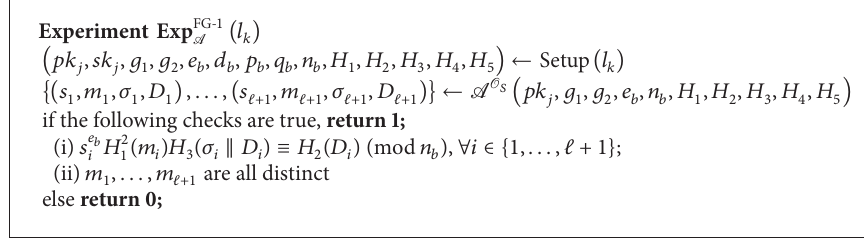
Algorithm 1: Experiment